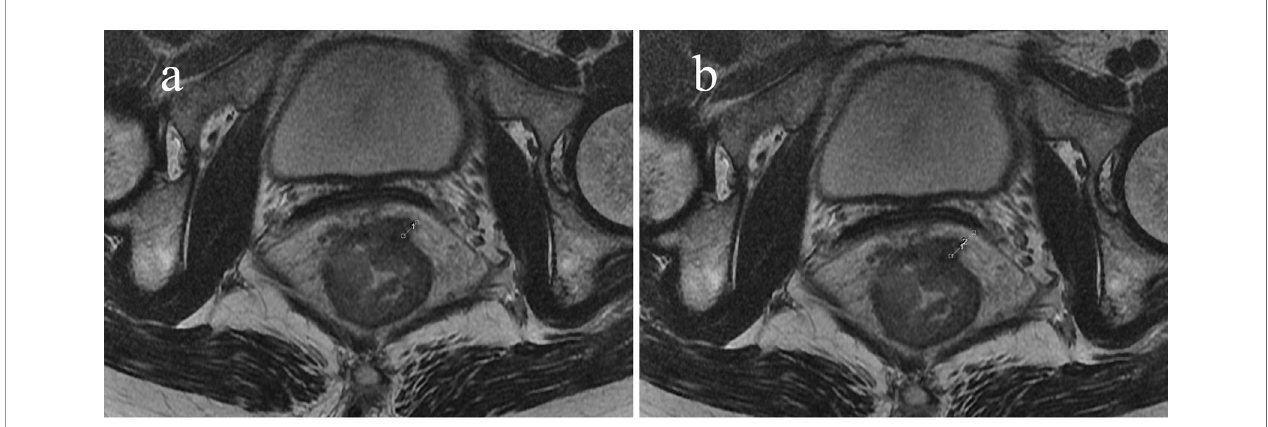
FIGURE 3 | Sixty-three-year-old woman with an mr-T3N0 rectal adenocarcinoma 5 cm from the anal verge. Pretreatment rectal MRI (A, B) before NCRT. The EMD was 6.1 mm (A) , TM was 10.5 mm (B) , and the calculated PTI was 58.1%. The rectal cancer had slightly regressed after NCRT. The postoperative staging con fi rmed by pathology was T3N0, and the tumor response was